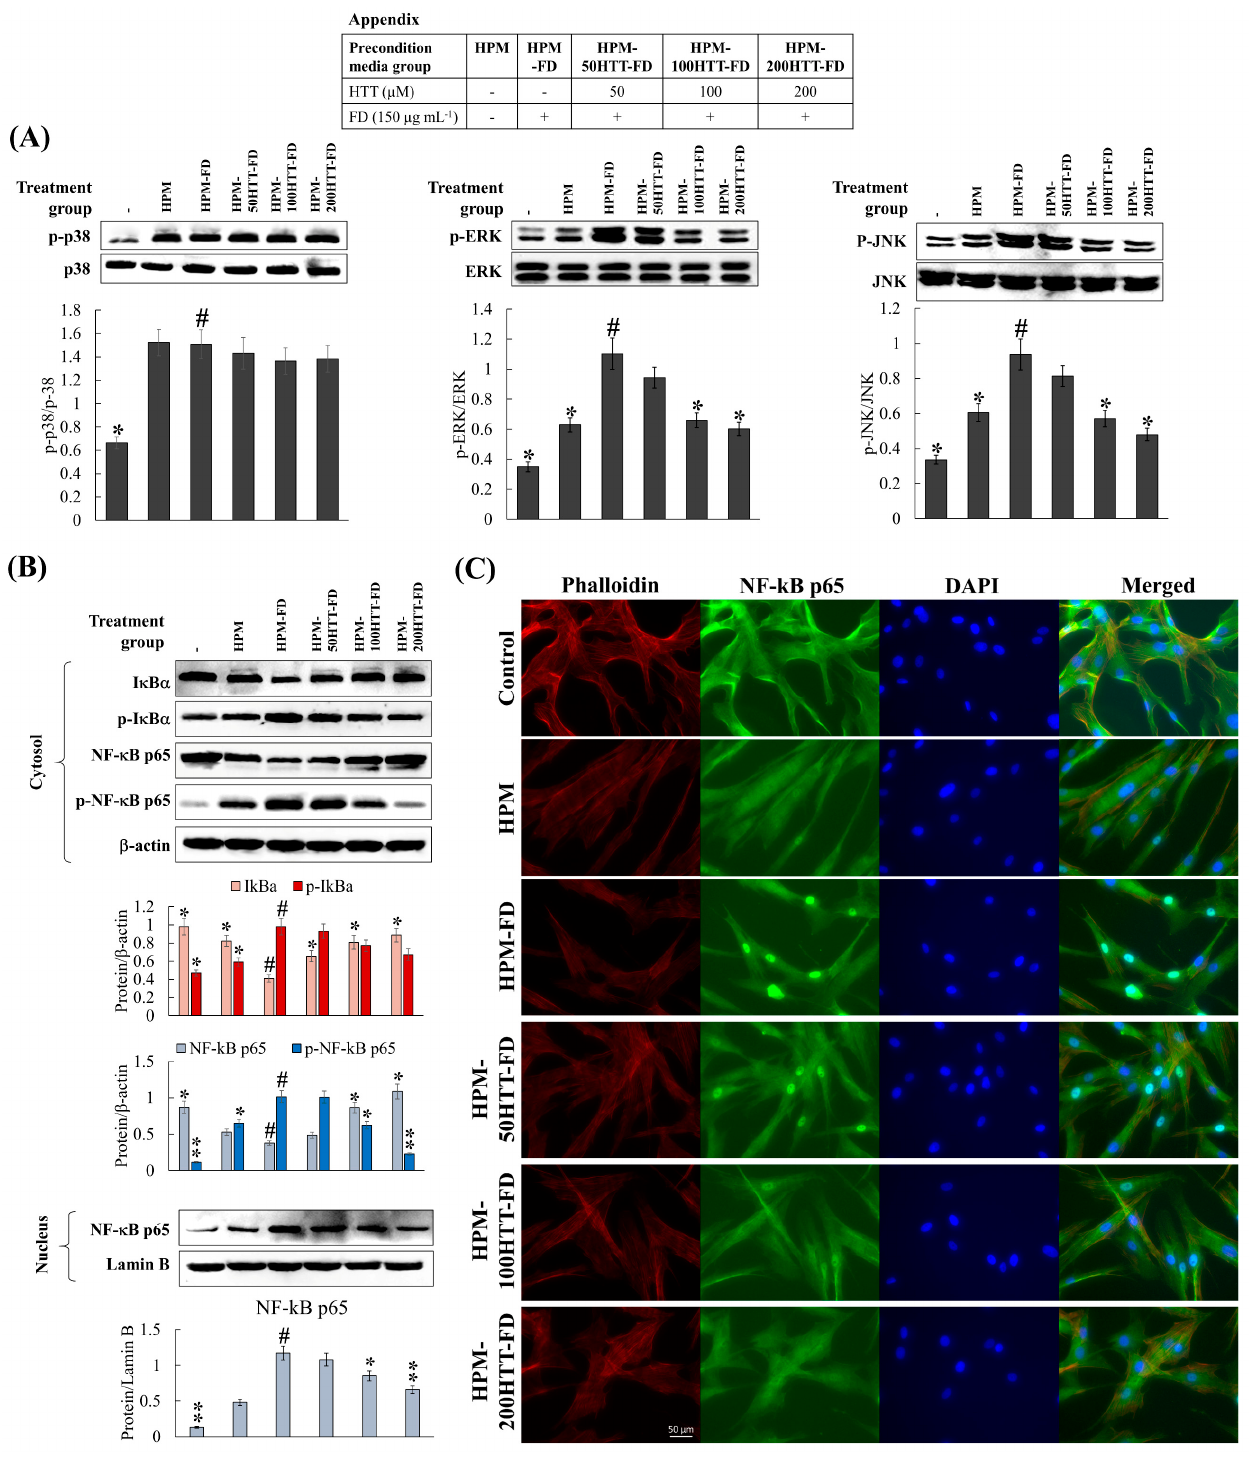
Figure 3. Effect of HTT priming in FD-stimulated HaCaT keratinocyte preconditioned media on MAPK derived NF- κ B inflammatory signaling in integrated HDFs. Levels of molecular mediators were assessed by western blot analysis for ( A ) MAPK and ( B ) NF- κ B. ( C ) Evaluation of NF- κ B p65 nuclear translocation by immunofluorescence analysis. Evaluations were carried out in triplicates ( n = 3) and indicated as means ± SD. “*” and “**” respectively denote p < 0.05 and p < 0.01 if they are significantly different from those of HPM-FD treated HDFs “#”.